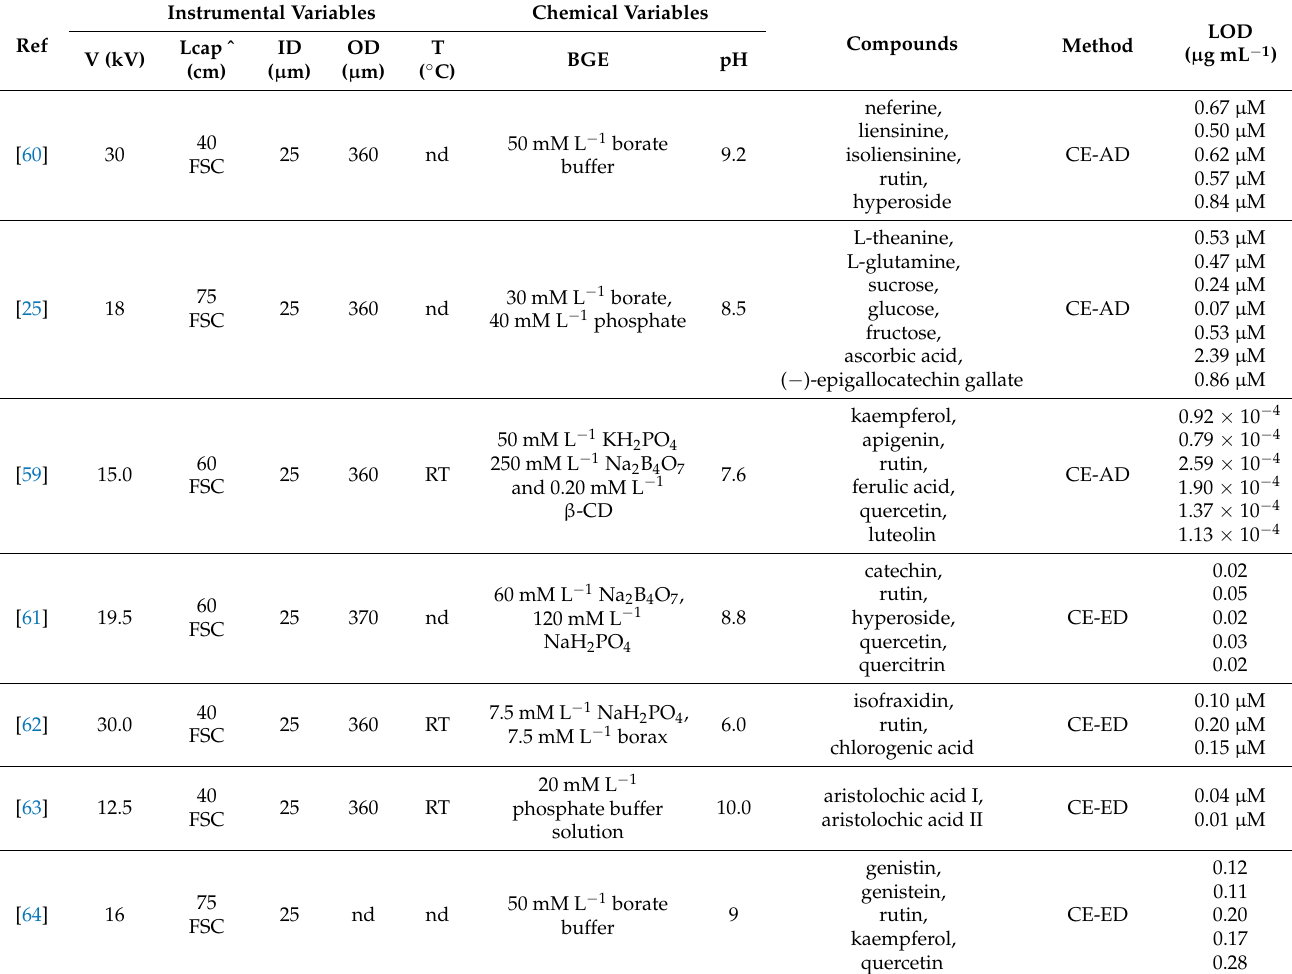
Table 3. Application of capillary electrophoresis with electrochemical